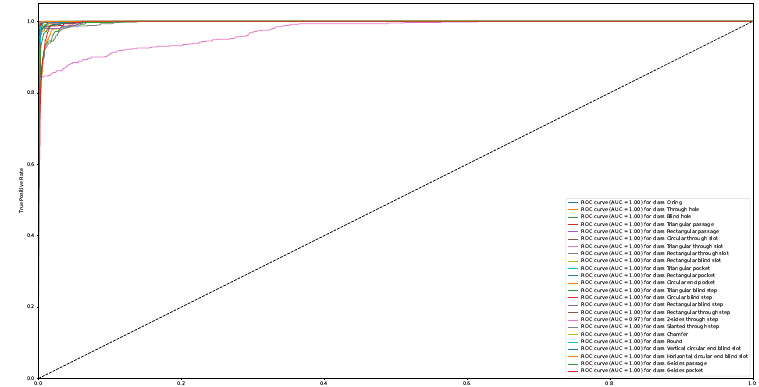
Figure A8. ROC curve for FeatureNet [14].